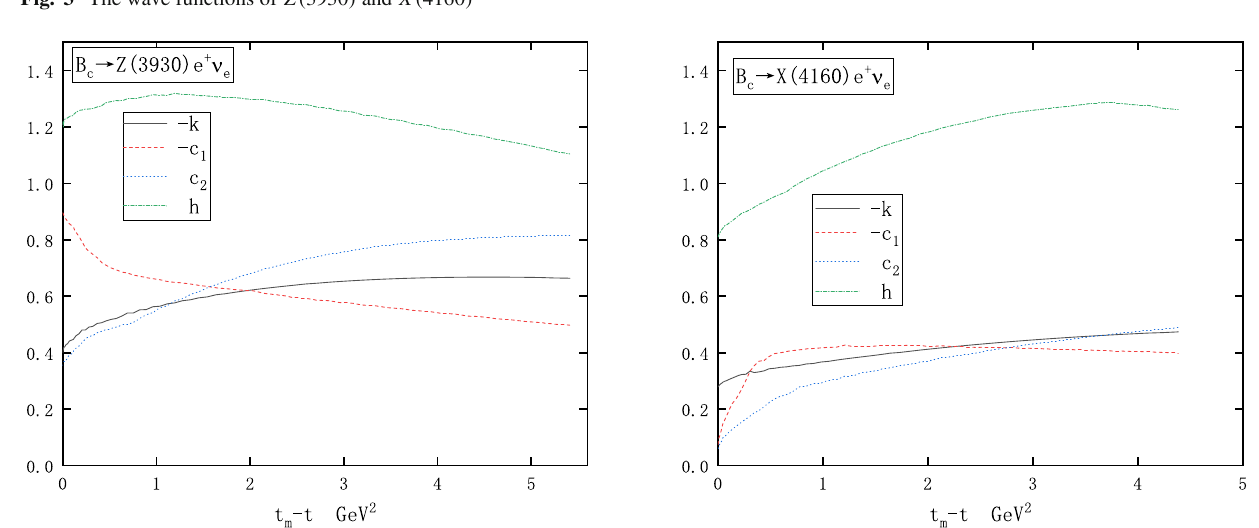
Fig. 3 The wave functions of Z ( 3930 ) and X ( 4160 )